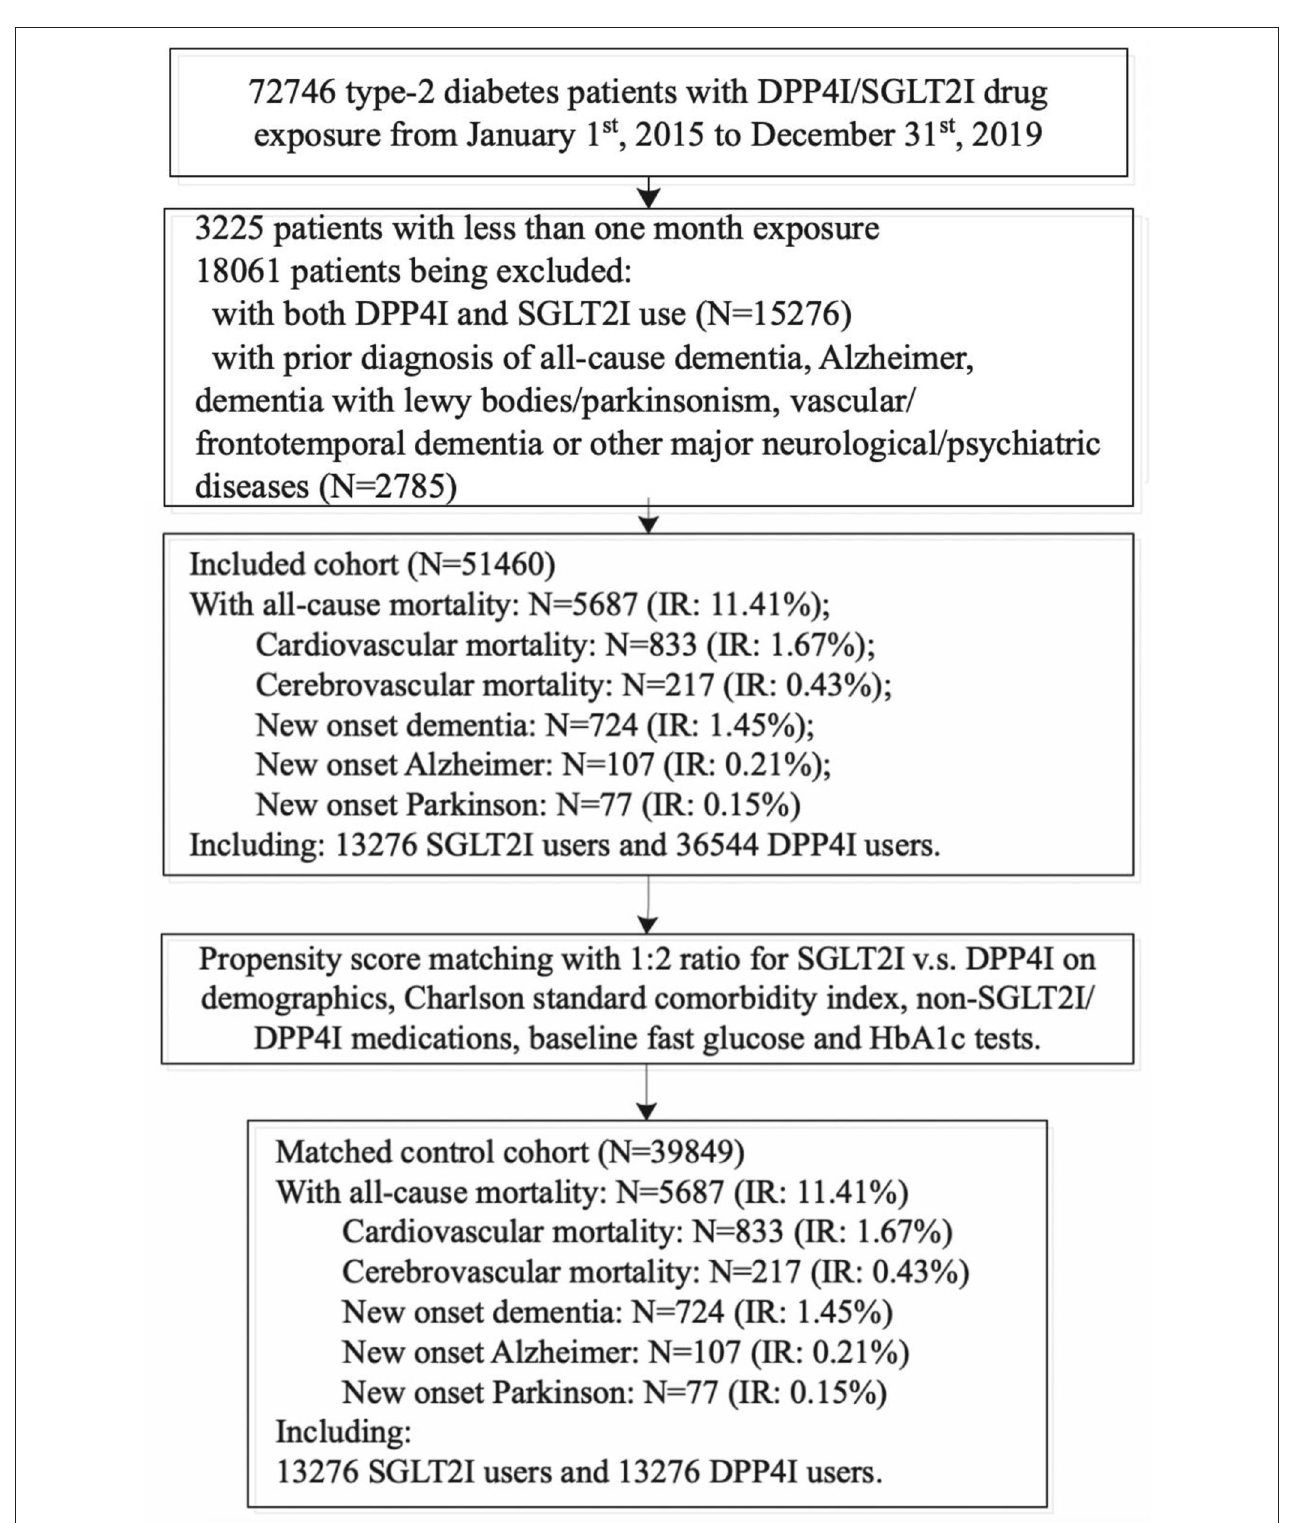
FIGURE 1 | Procedures of data processing for the study cohort.